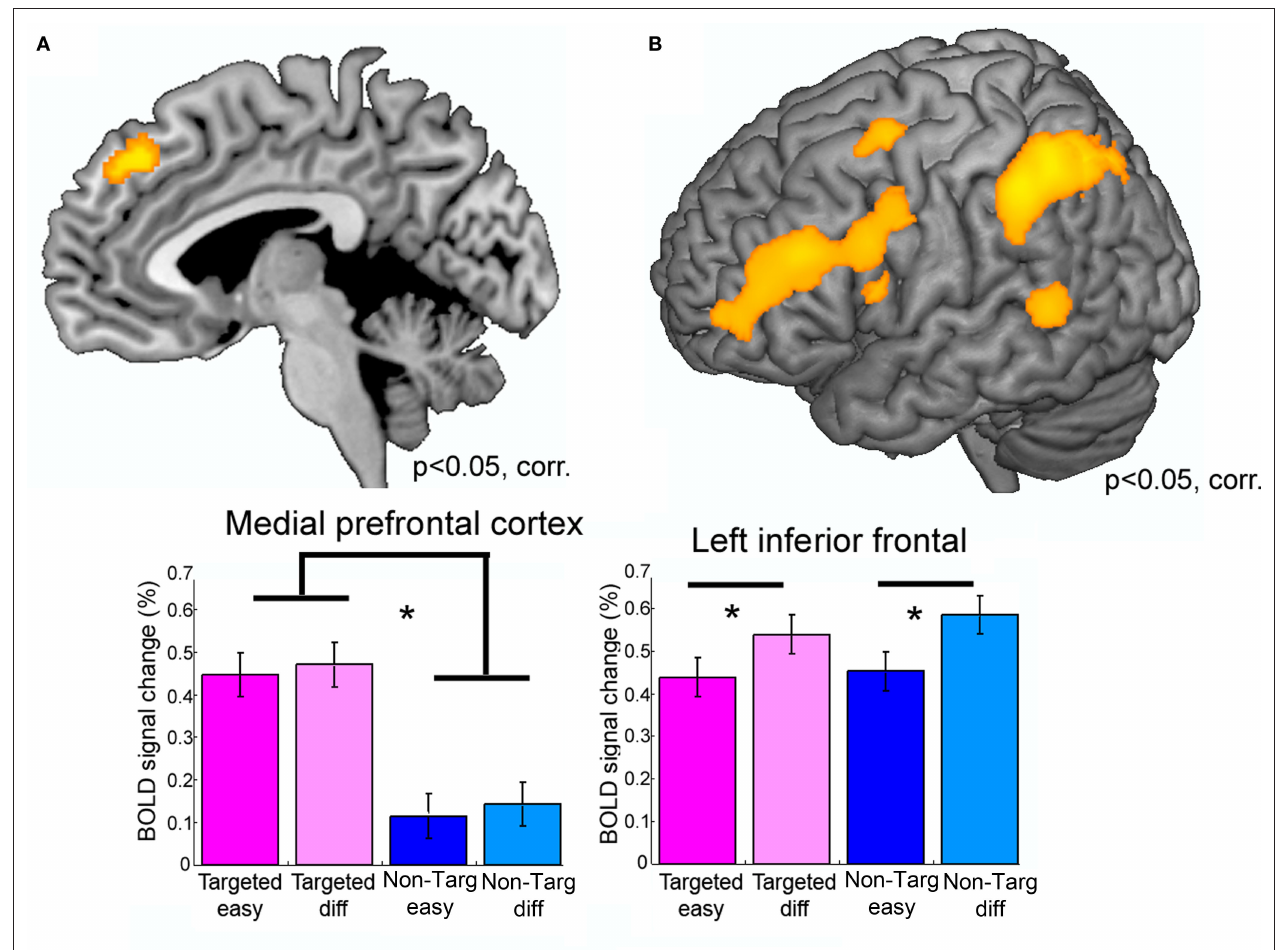
more difficult to come up with a description, or were semantically less closely related to the Target word, which makes it more Easy to come up with a description. (A) Shows the result of comparing Targeted versus Non-Targeted trials, (B) shows results of the Difficult versus Easy comparison. The results show that medial prefrontal cortex was sensitive to the Communicative intent manipulation (A) , but not to the linguistic difficulty manipulated, whereas an opposite pattern was observed in left inferior frontal cortex (B) . Figure adapted from Willems et al.